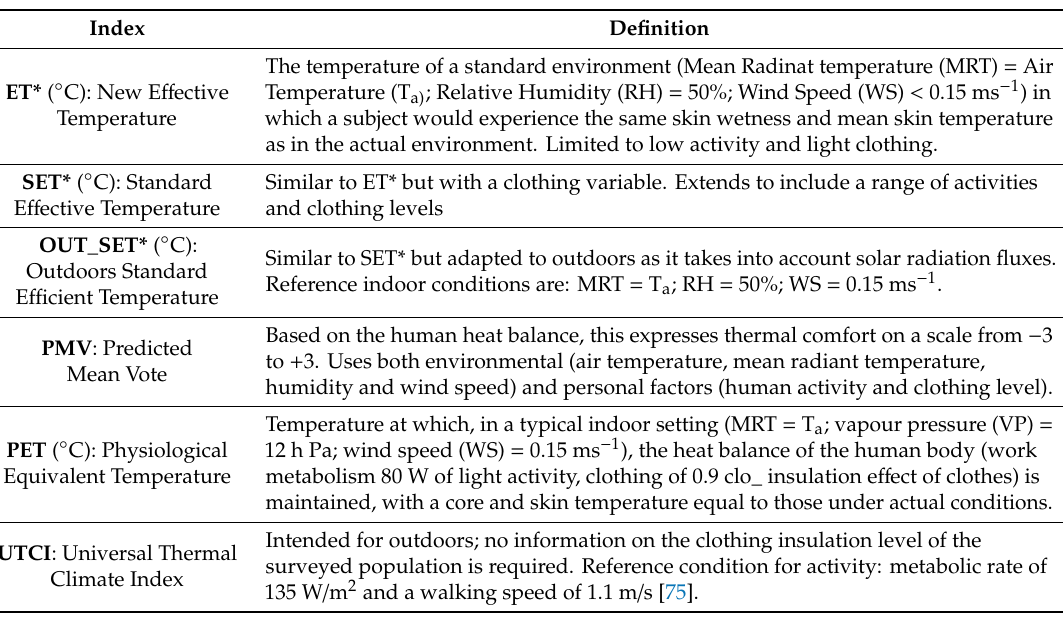
Table 2. The most widely used thermal comfort indices